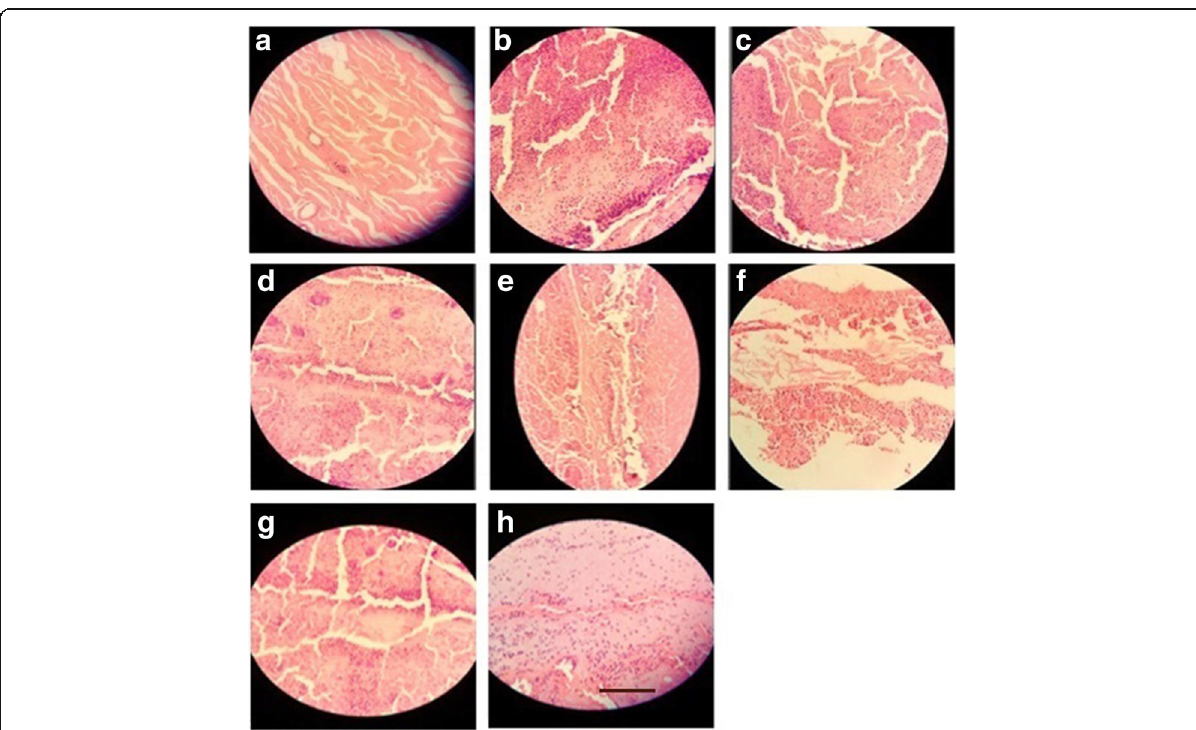
Fig. 3 Histopathological changes in the skin; a : Group I = Normal control, b : Group II = Diabetic wound control, c: Group III = Diabetic wound control +100 mg ethanolic extract of E. hirta , d : Group IV = Diabetic wound control +200 mg ethanolic extract of E. hirta , e : Group V = Diabetic wound control +400 mg ethanolic extract of E. hirta , f : Group VI = Diabetic wound control +5% Povidone iodine, g : Group VII = Diabetic wound control +5% ethanolic extract of E. hirta , h : Group VIII = Diabetic wound control +10% ethanolic extract of E. hirta . Each group was assessed at 400X magnification, scale bar: 40 μ